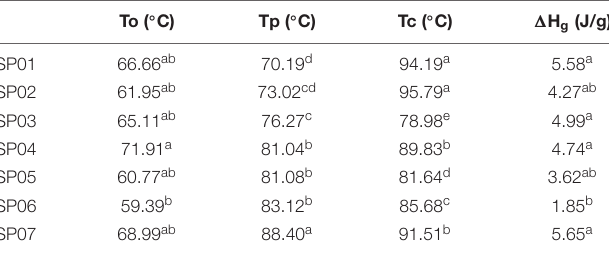
TABLE 6 | Gelatinization properties of different varieties of sweet potato